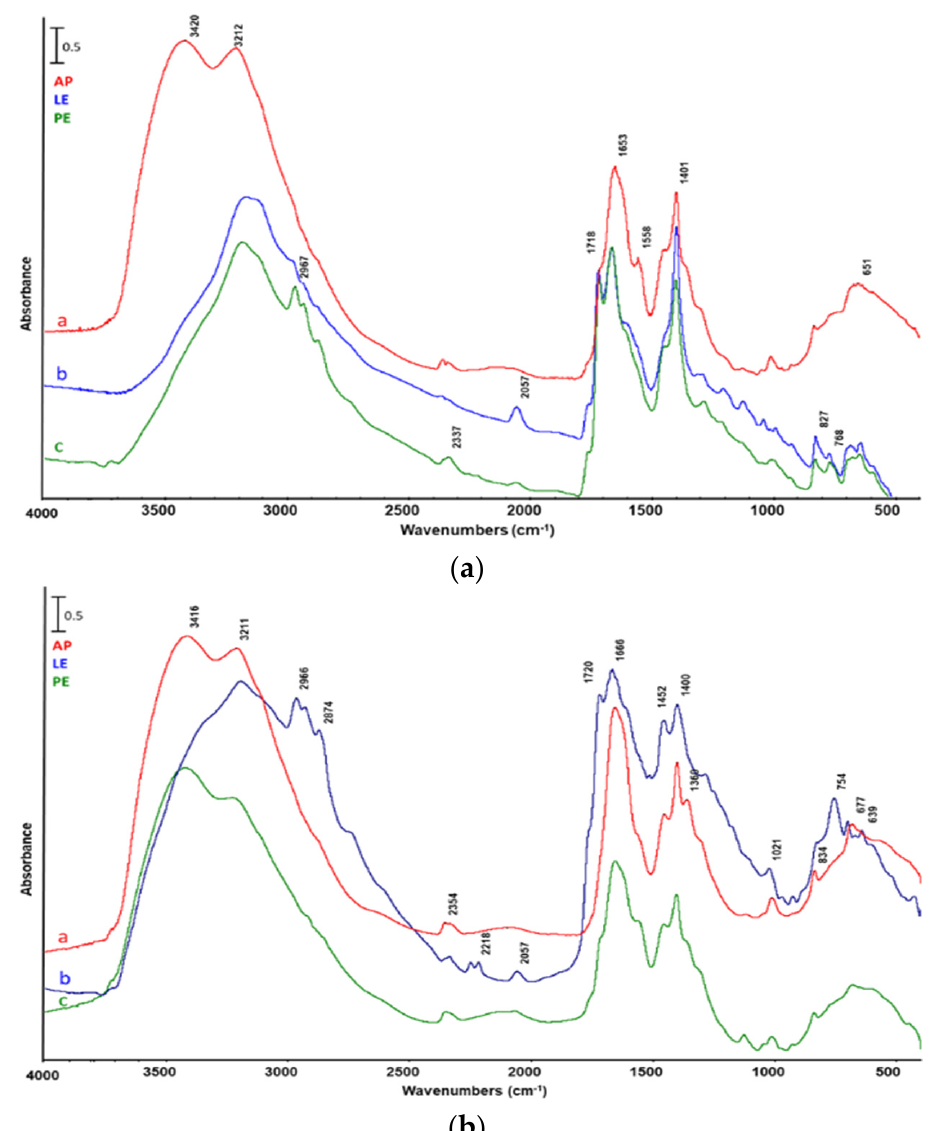
Figure 7. FTIR analysis of heavy reaction liquid from catalytic pyrolysis of a— Arthrospira platensis untreated biomass (AP), b—biomass after lipid extraction (LE), and c—biomass after protein extraction (PE). Catalyst: ( a ) ZSM5, ( b ) silica–alumina.